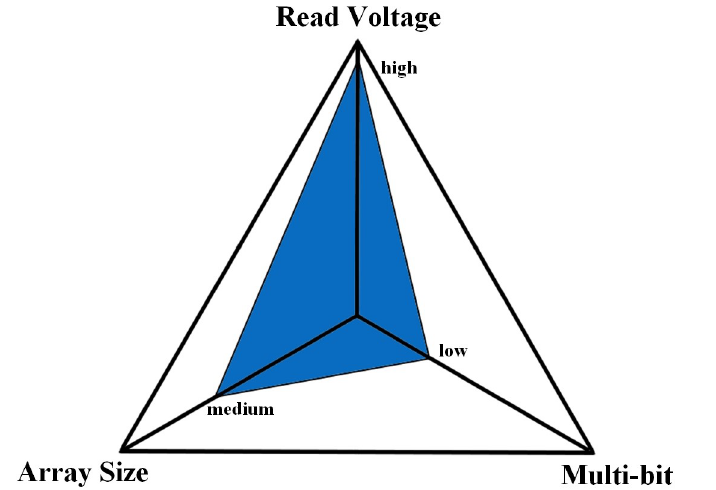
Figure 11. The influence intensity of design parameters on leakage